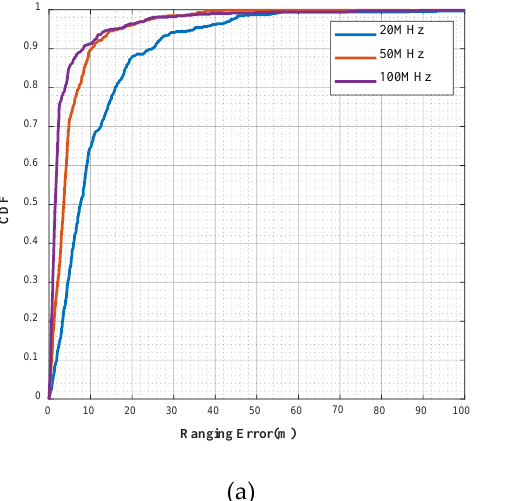
Table 3. Direct path identification rate of NC-MUSIC in UMi scenario with 20 MHz, 50 MHz and 100 MHz bandwidth.